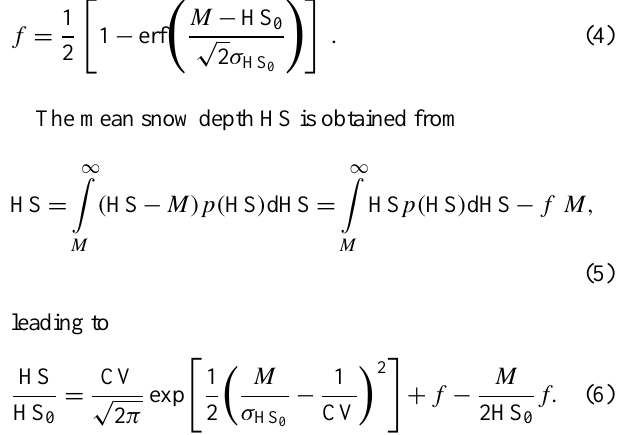
Figure 8. Measured standard deviation of snow depth σ m tion of parameterized standard deviation of snow depth σ HS for all three areas. (a) Parameterized via Eq. (2), (b) parameterized via Egli and Jonas (2009) and (c) parameterized via Pomeroy et al. (2004). Colors indicate corresponding domain size L . NRMSEs are given for each